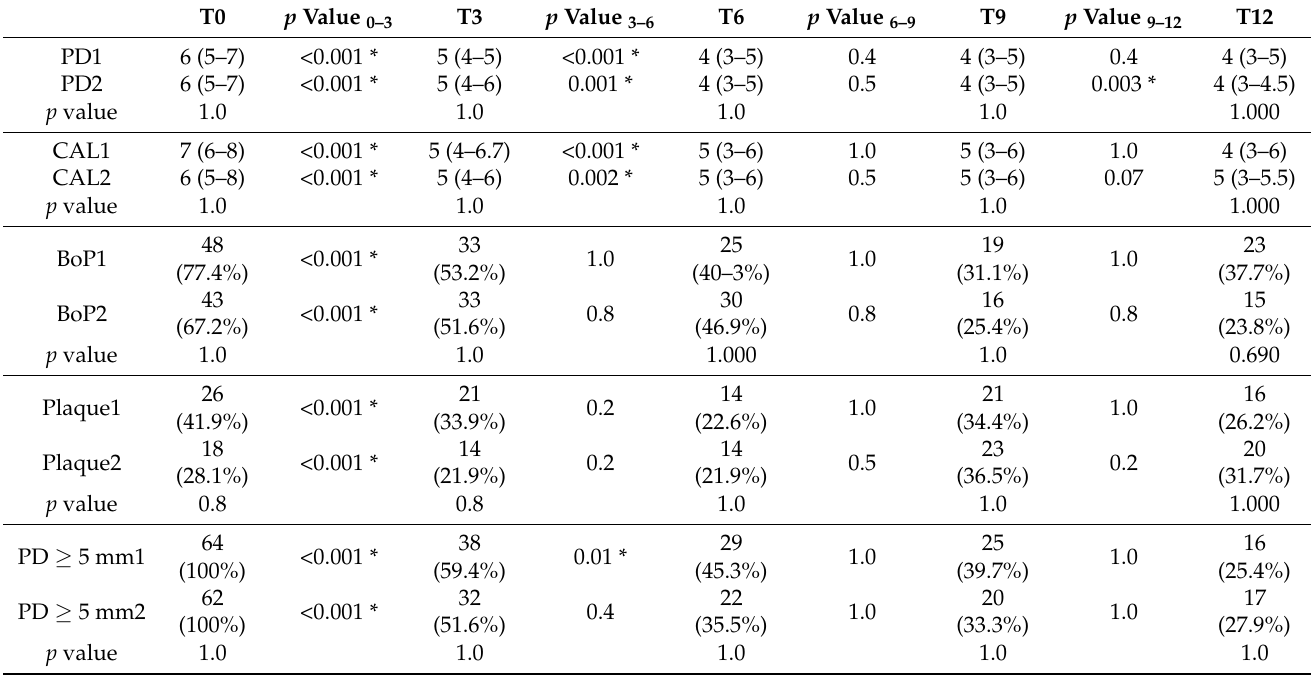
Table 1. Clinical parameters and differences between groups and between different